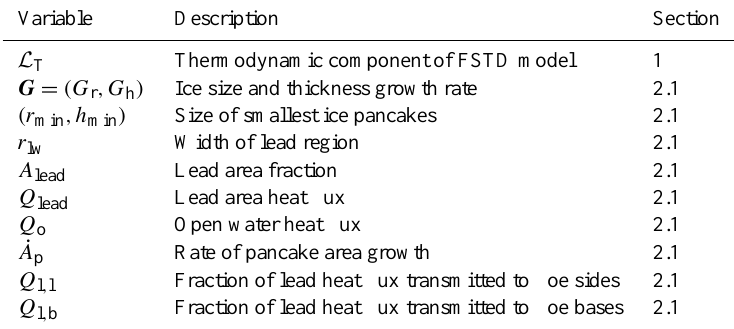
Table 2. Variables used in the representation of thermodynamical processes in the FSTD model.